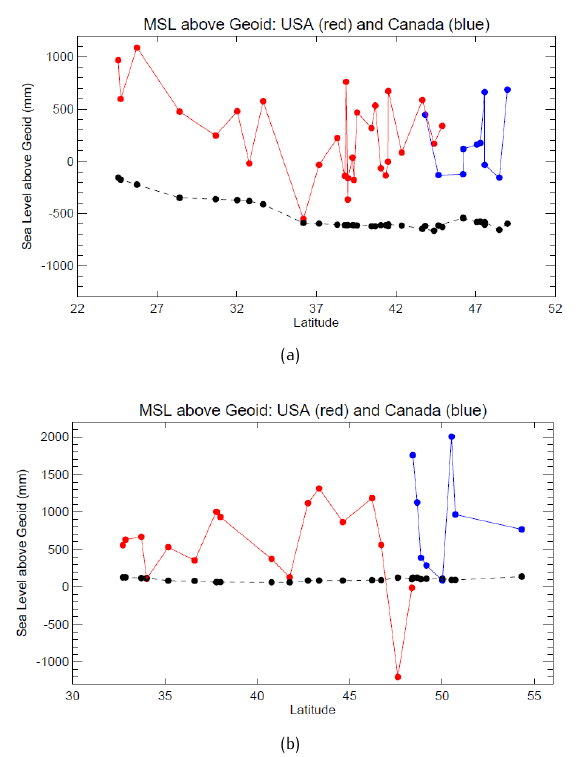
Figure 3. (a) As Figure 2(a) but with values of MSL determined as geocentric heights above the reference ellipsoid and are shown relative to values of the geoid from the GOCO03S model. (b) A similar set of points for the Pacific coast of North